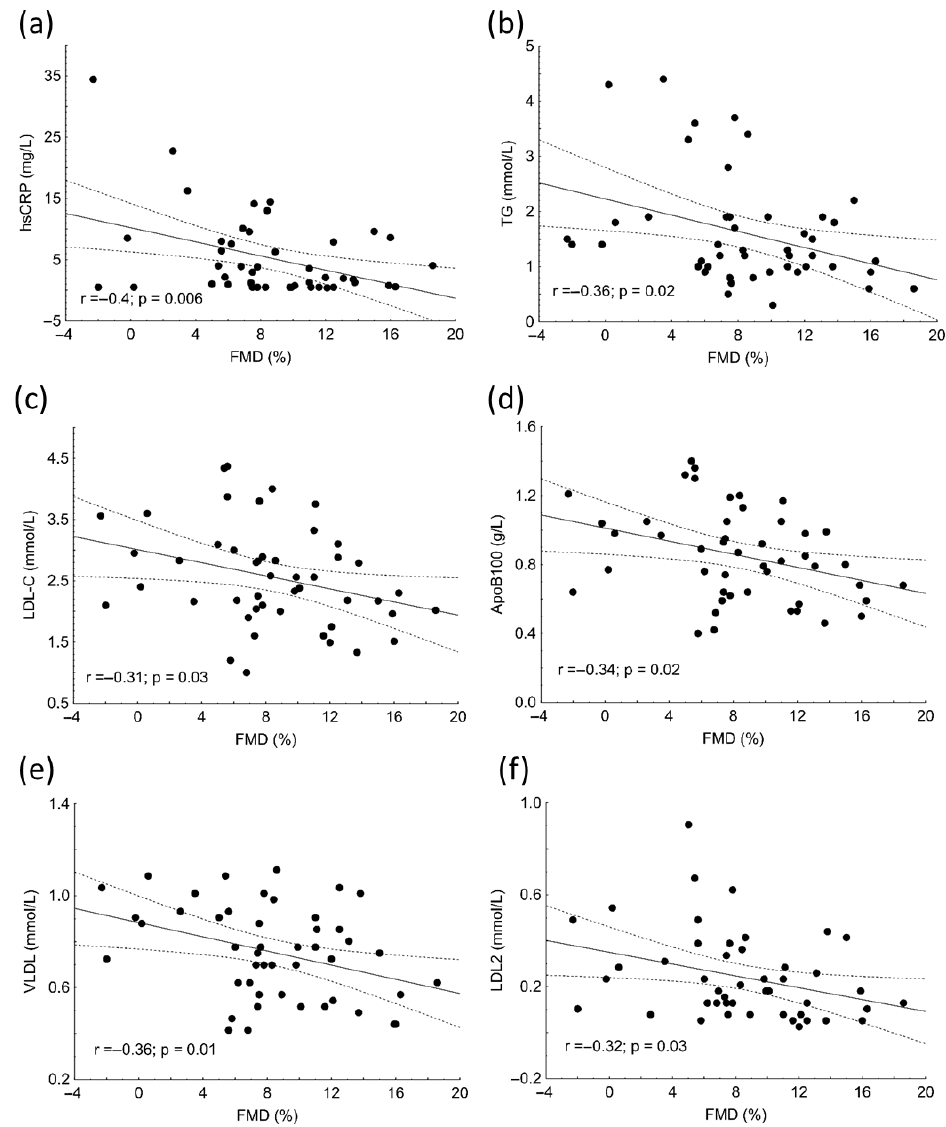
Figure 2. Correlations between high-sensitivity C-reactive protein (hsCRP) ( a ), triglyceride (TG) ( b ), low-density lipoprotein cholesterol (LDL-C) ( c ), apolipoprotein B (ApoB) ( d ), very low-density lipoprotein (VLDL) subfraction ( e ), LDL2 subfraction ( f ) and flow-mediated dilation (FMD) in patients with systemic lupus erythematosus (SLE).